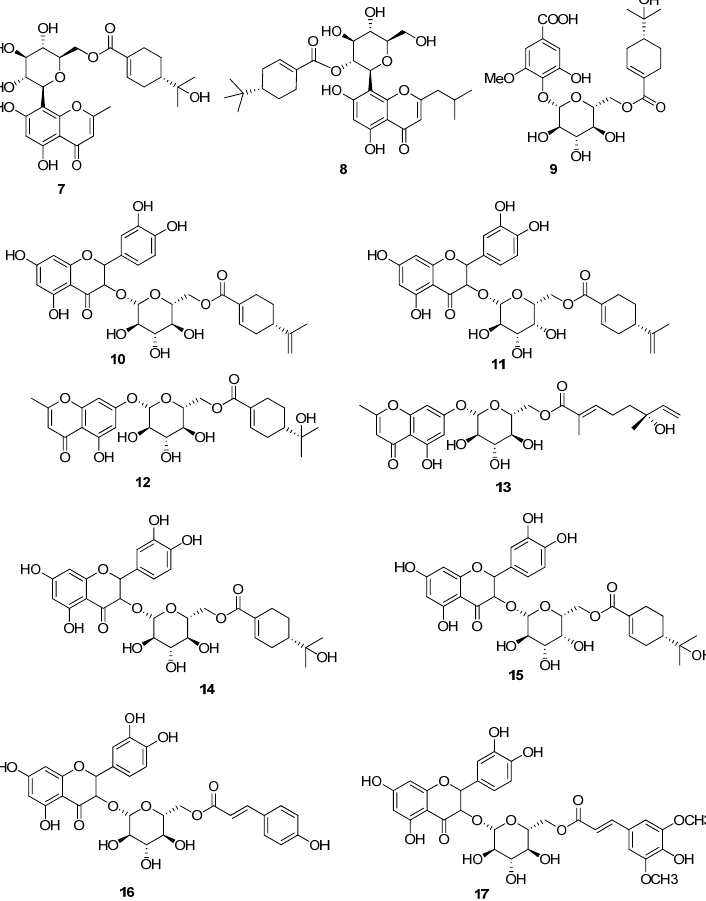
Figure 2. Acylated Phenolic Glycosides ( 7 – 17 ) were isolated from the leaves of the P. guajava L.